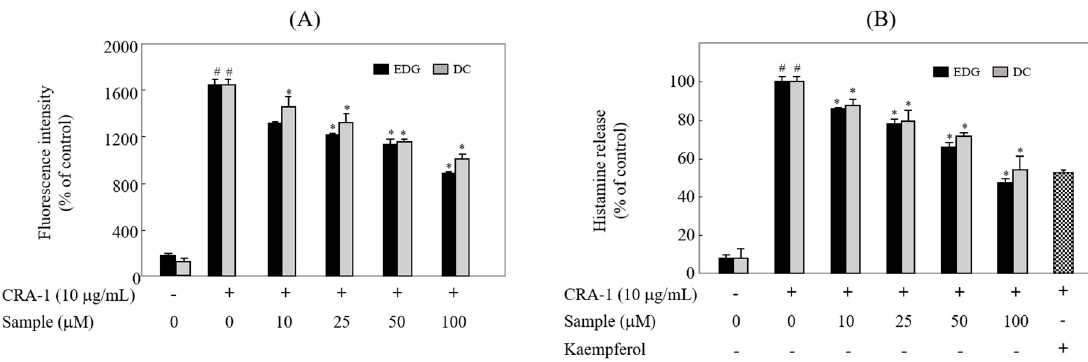
Figure 6. EDG and DC inhibited Fc ε RI-mediated calcium influx and degranulation. Cells treated with various concentrations of EDG and DC under serumfree conditions. ( A ) Cells incubated with Fura 2-AM and stimulated with CRA-1 to determine calcium influx. ( B ) To examine histamine content in the medium, cells were stimulated with CRA-1, and supernatants were treated with o -phthalaldehyde (OPA). These cells were determined via a spectrofluorometric method. Each value expressed as mean ± SD of three different experiments. # p < 0.05 vs. non-treated group; * p < 0.05 vs. CRA-1-treated group.